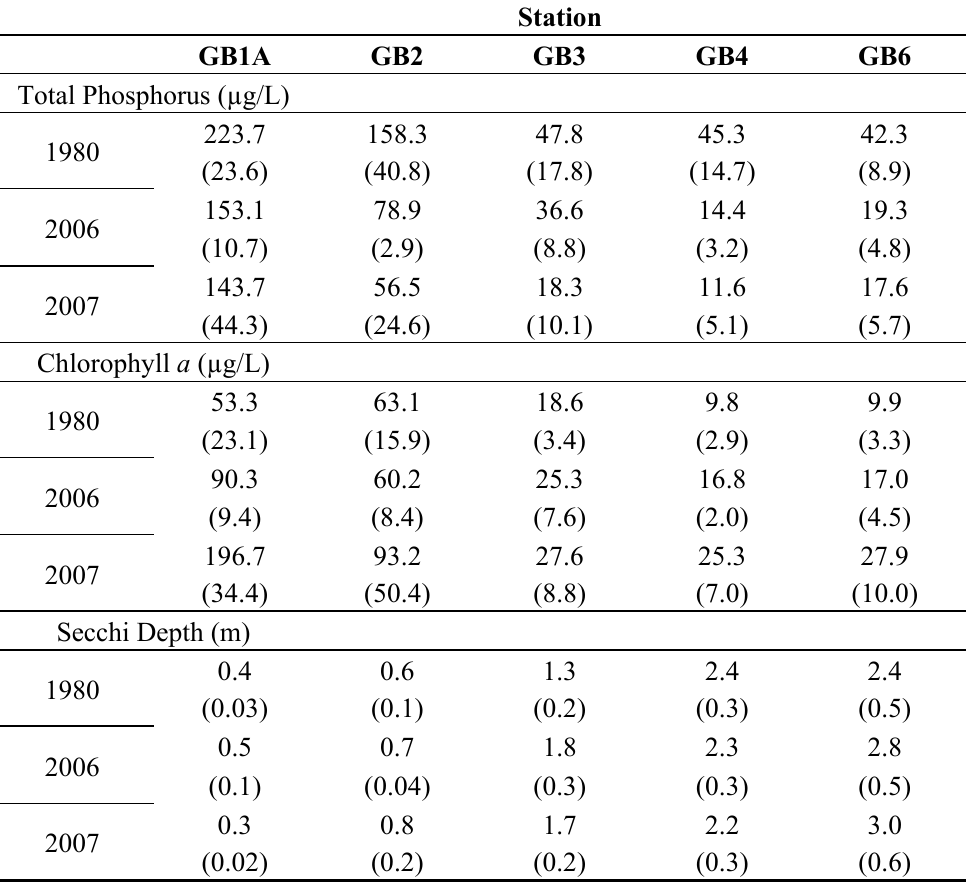
Table 4. Examples of mean summer water quality indicators along the trophic gradient in Green Bay before (1980) and after (2006, 2007) invasion by dreissenid mussels. Mean values are shown with 1 standard error of the mean indicated in